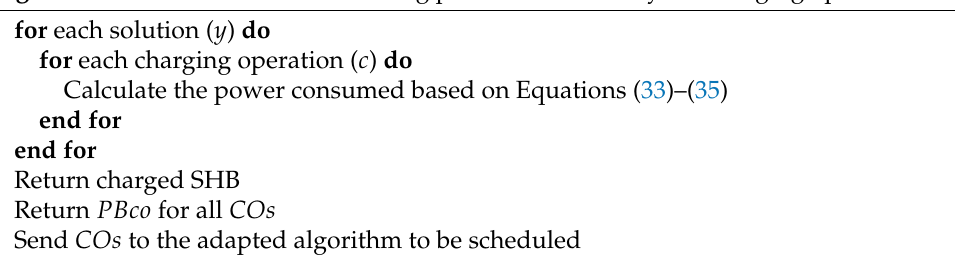
Algorithm 3 Pseudocode for calculating power consumed by the charging operation for each solution ( y )